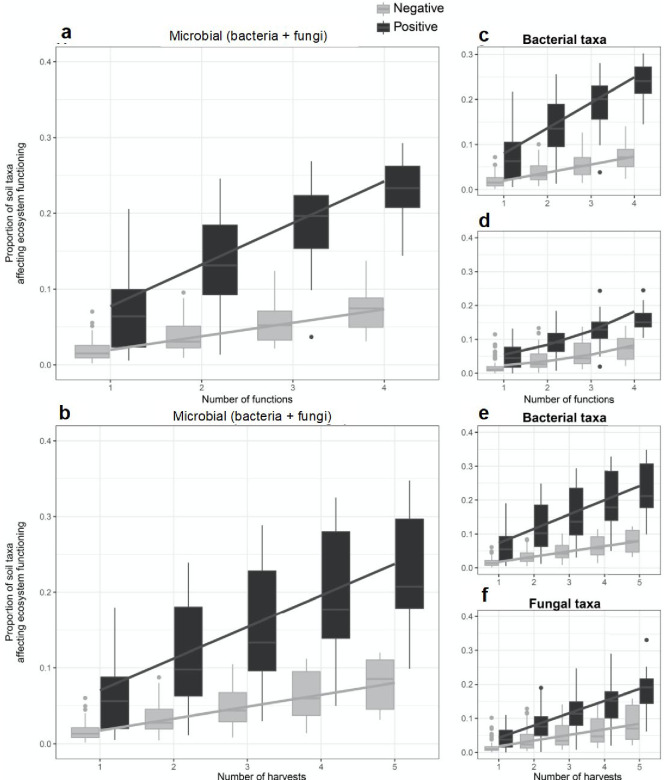
The proportion of soil microbes that support ecosystem functions increases with the number of functions and time points considered.A higher proportion of soil taxa affected ecosystem functioning, both positively (black bars) and negatively (grey bars), when more ecosystem functions (a, c, d) and number of time points (b, e, f) were independently considered. This result was found for the scaled average of fungal and bacterial taxa (a, b), the soil bacterial (c, e), and soil fungal taxa (d, f). Regression lines indicate generalized linear model fits and box plots summarize observed data.